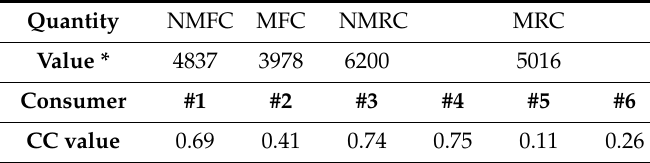
Table 2. Cost and privacy values computed for Scenario 1. * Values expressed in US Dollars